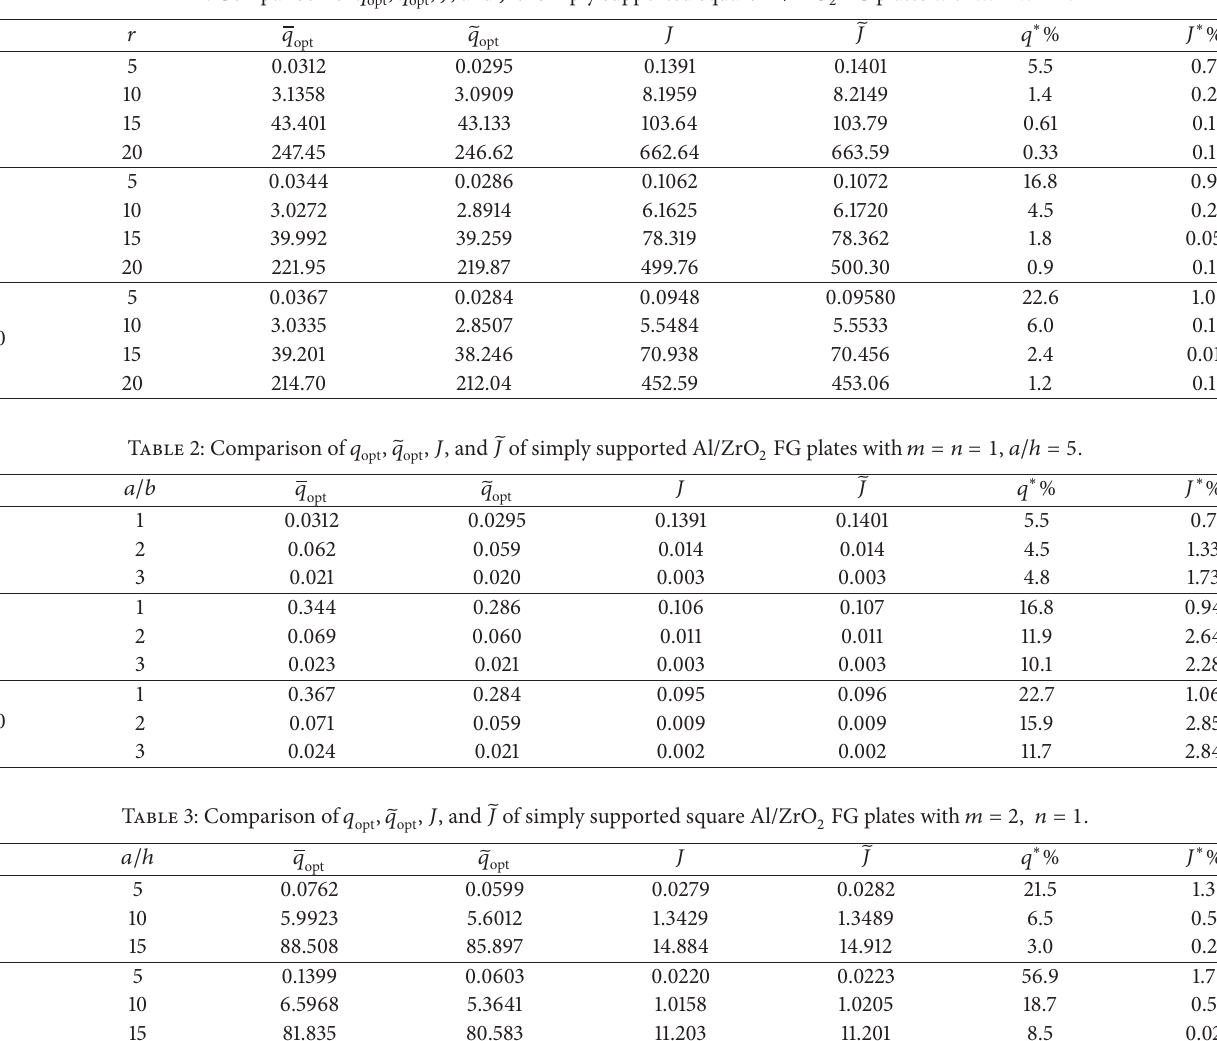
Table 1: Comparison of 𝑞